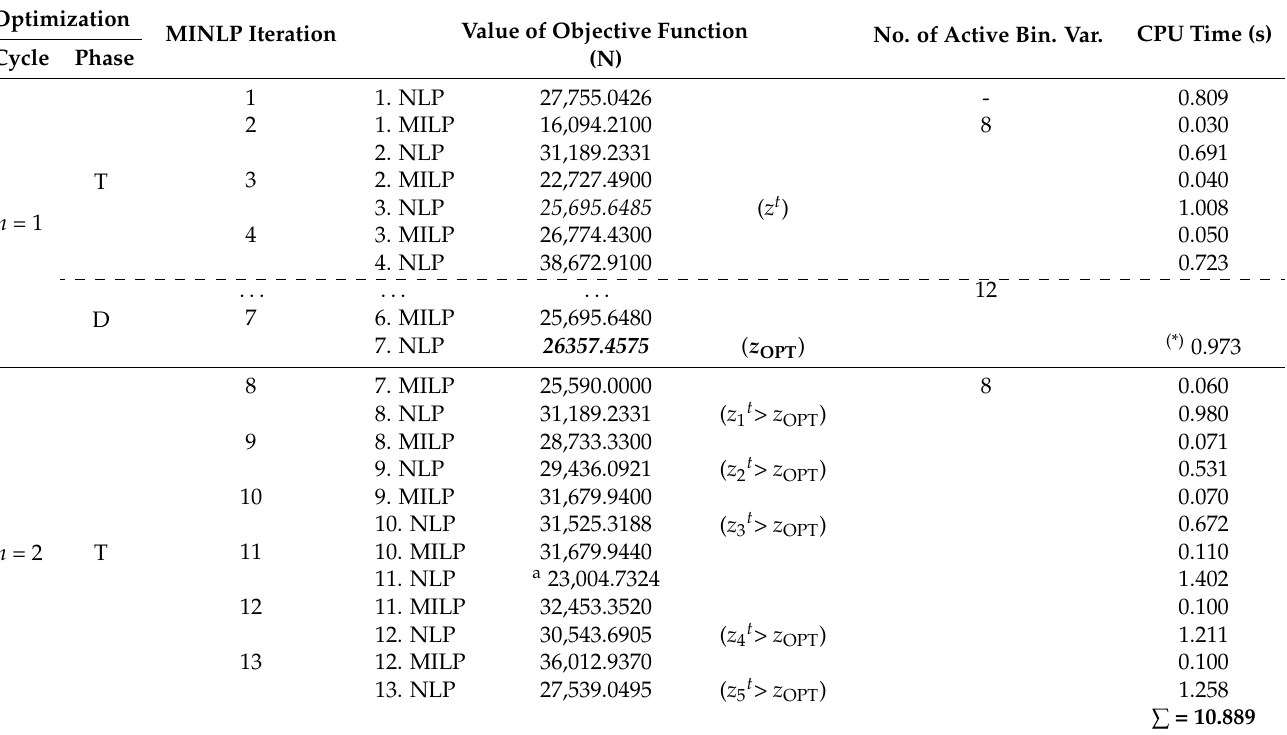
Table A3. Convergence of the Modified OA/ER algorithm and the MTP strategy, example TC10d (topology and shape optimization, with buckling